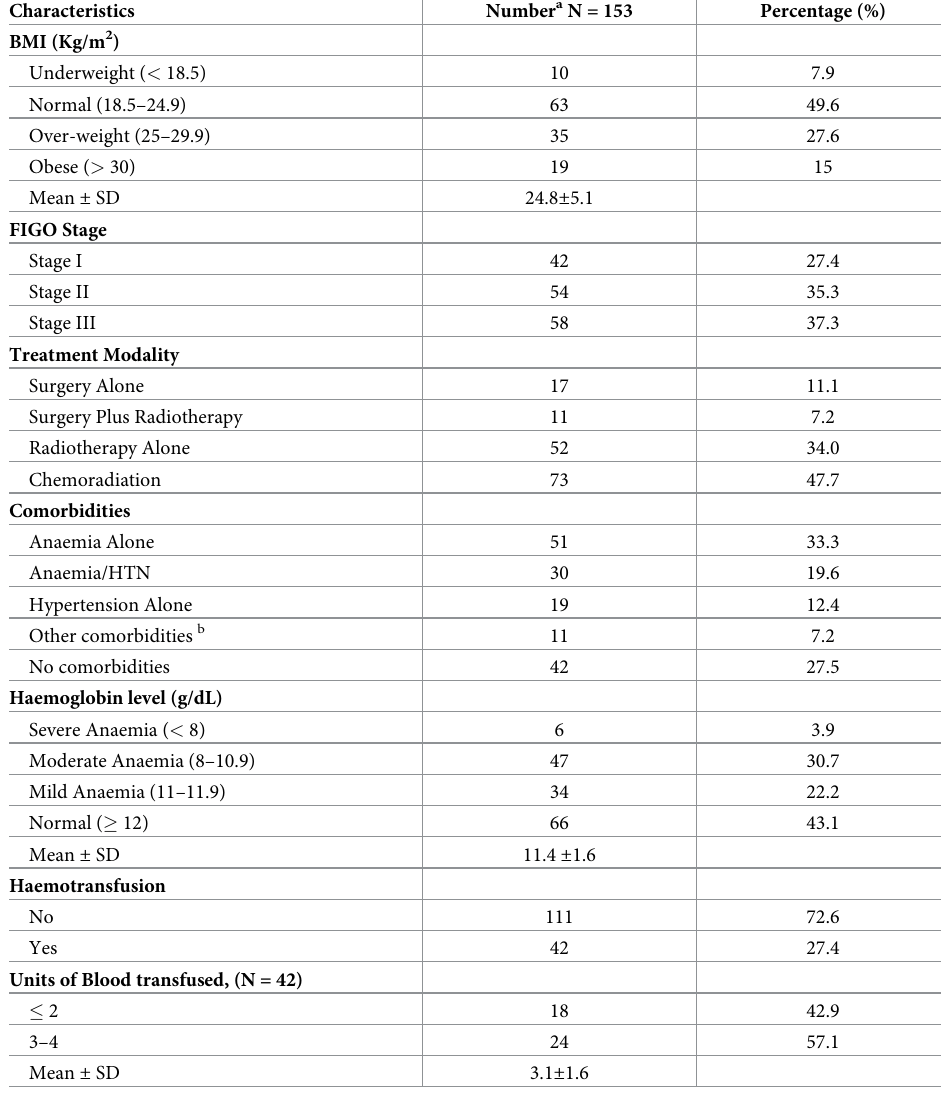
Table 2. Clinical characteristics of cervical cancer survivors during treatment.